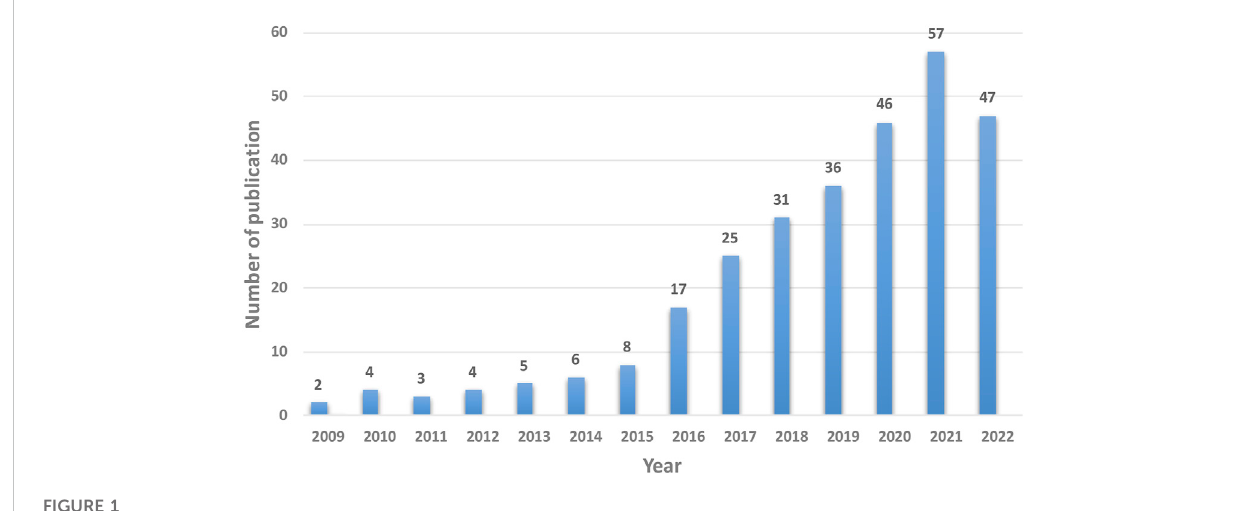
FIGURE 1 The annual trends of publications.